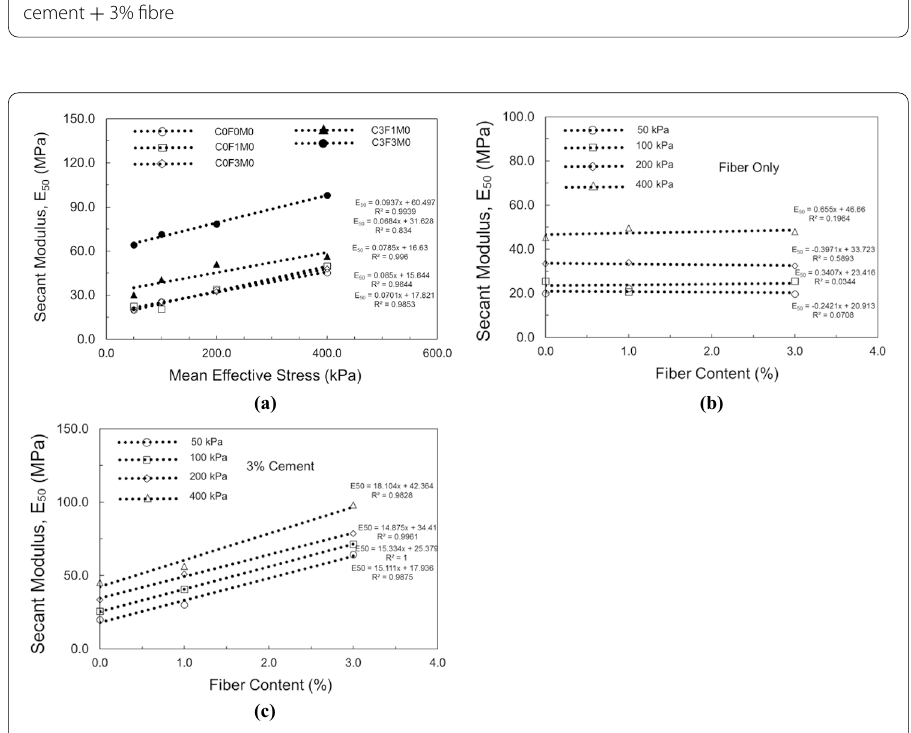
Fig. 5 Secant modulus (E 50 ) from CID tests for unreinforced, fibre, and fibre reinforced cemented Toyoura sand specimens consolidated to varying mean effective stresses ( p’ ) a Secant modulus versus mean effective stress b Secant modulus with fibre content only c Secant modulus versus 3% cement